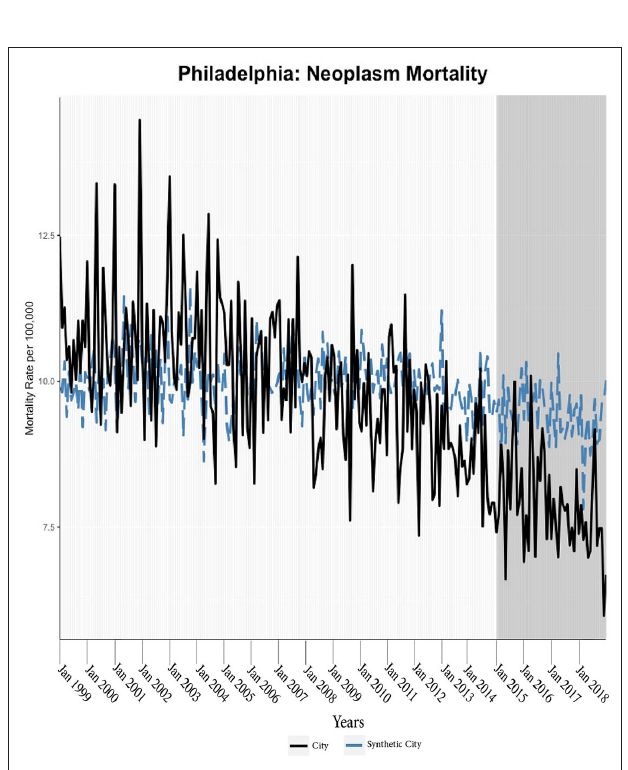
FIGURE 8 | Neoplasm mortality trends: Philadelphia and synthetic control city.